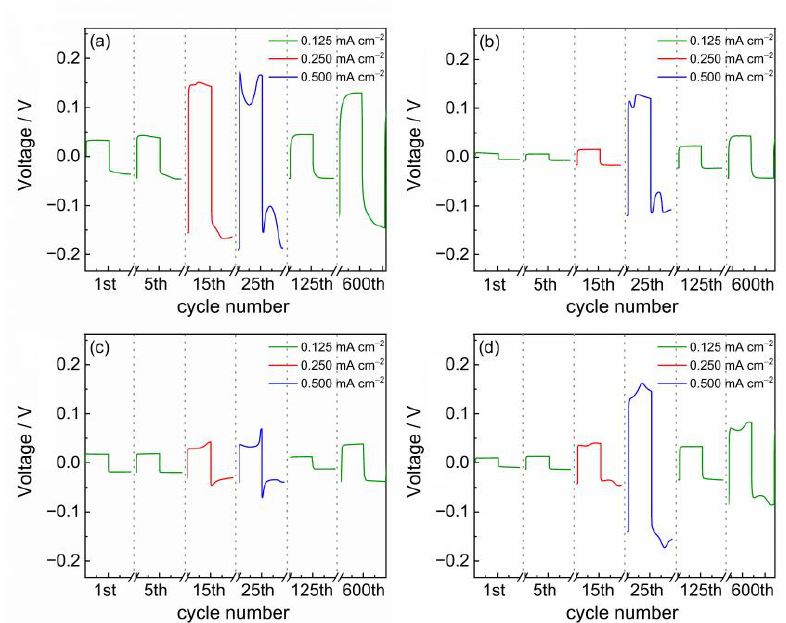
Figure 8. Selected overvoltage profiles of lithium deposition/stripping of Li||Li symmetric cells with ( a ) PC, ( b ) PC-NH 4 PF 6 , ( c ) PC-TMAPF 6 , ( d ) PC-TEAPF 6 electrolytes at 0.125 mA cm −2 (green), 0.250 mA cm −2 (red) and 0.500 mA cm −2 (blue).